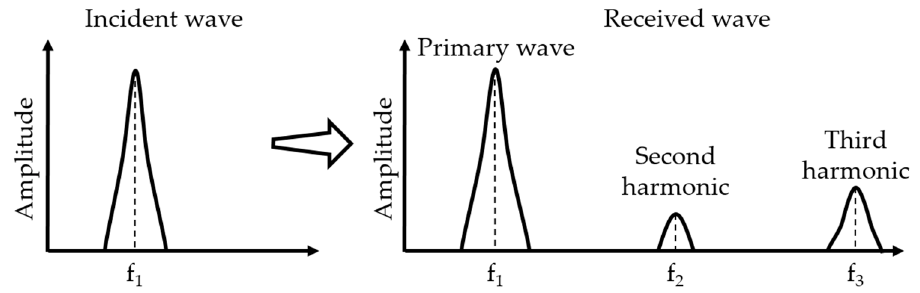
Figure 2. Spectrum changes through nonlinear media.